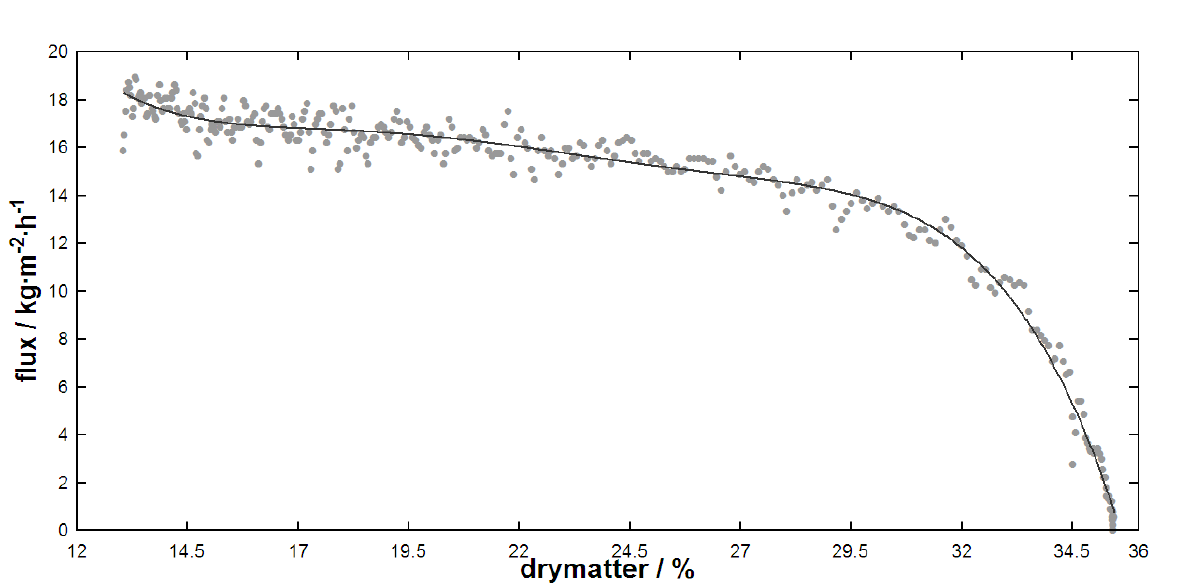
Figure 7. Flux during DCMD of a lactose powder solution.